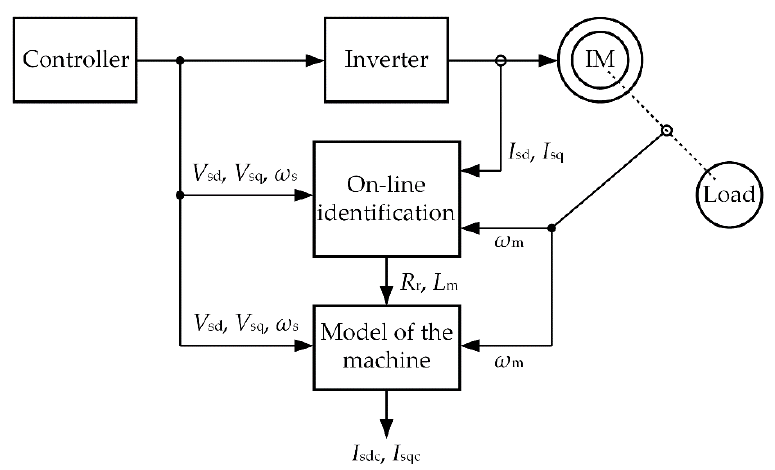
Figure 9. Verification block scheme.